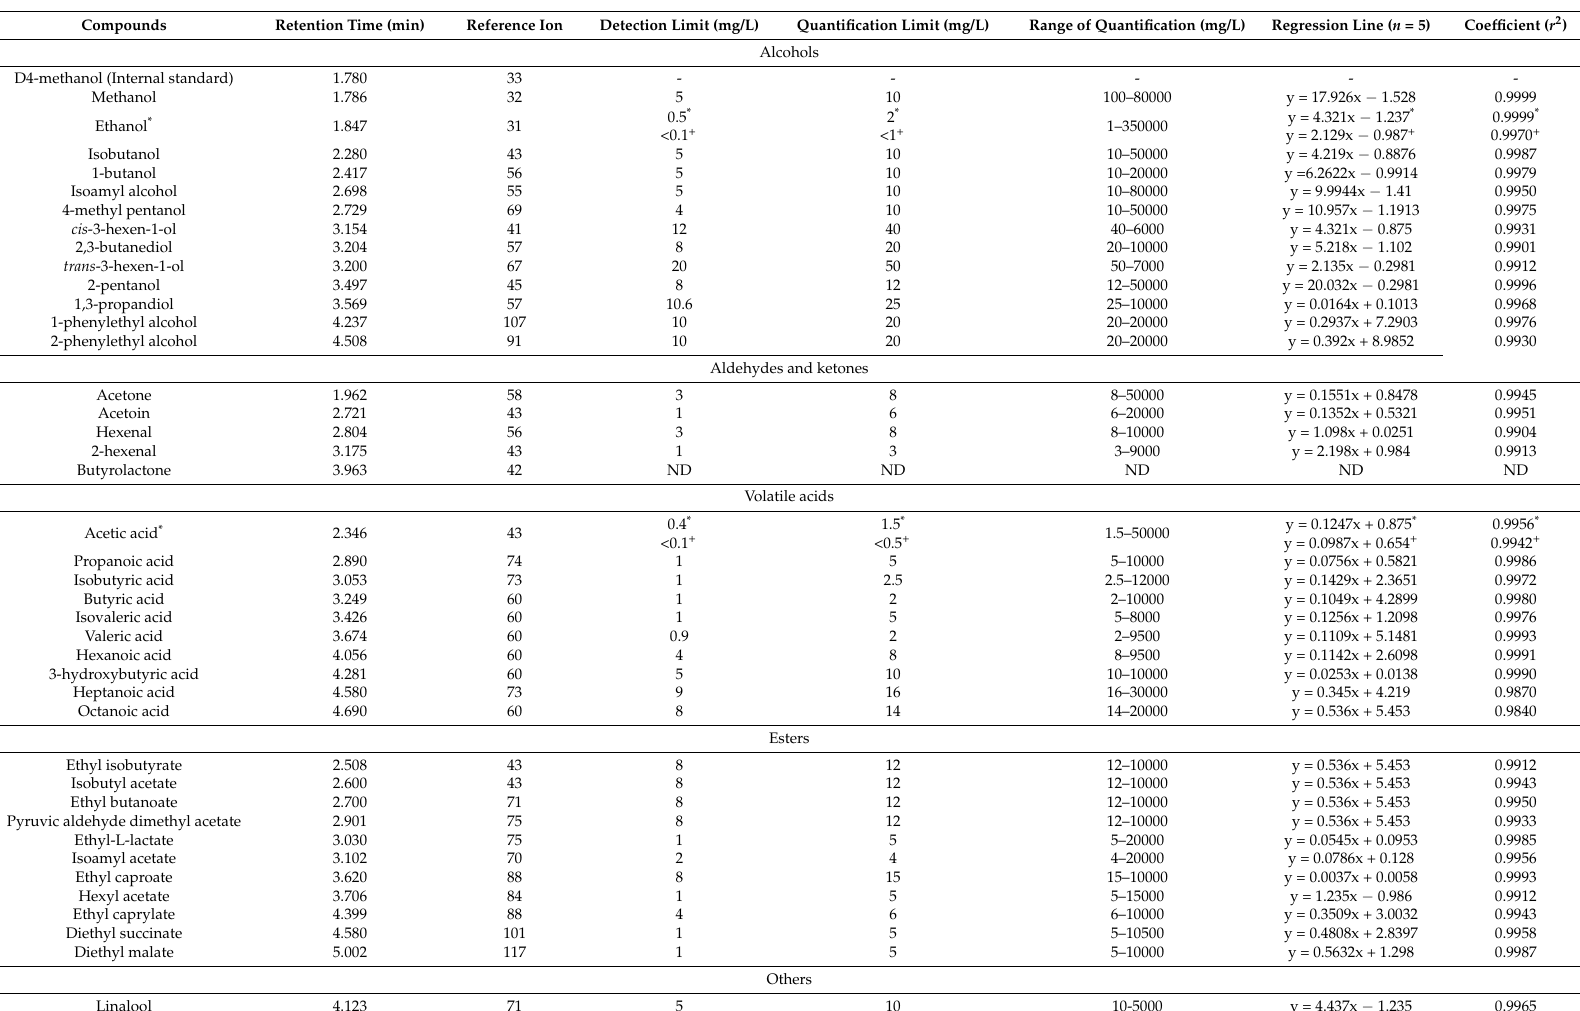
Table 1. The analytical characteristics of volatile metabolites detected and identified by Gas-Chromatography and Mass-spectrometry method. Compounds Retention Time (min) Reference Ion Detection Limit (mg/L) Quantification Limit (mg/L) Range of Quantification (mg/L) Regression Line ( n = 5) Coefficient ( r 2 ) Alcohols D4-methanol (Internal